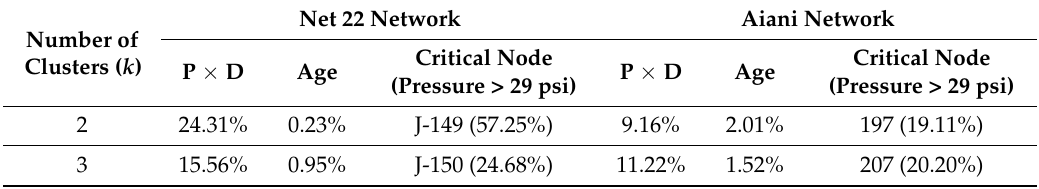
Figure 3. ( a ) Net 22, ( b ) Aiani Network. Table 1. Reduction rates based on the various values of k (number of clusters) for both